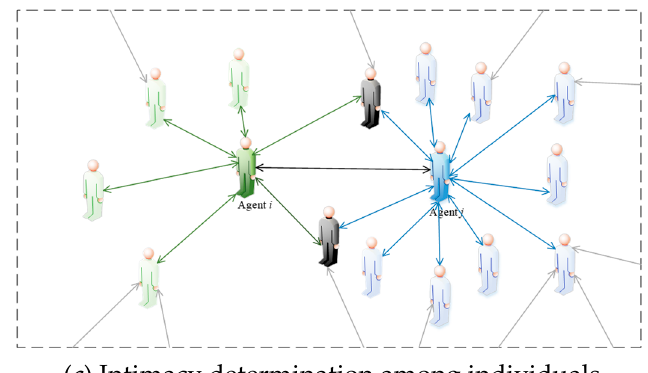
Figure 4. Diagram of intimacy h ij.